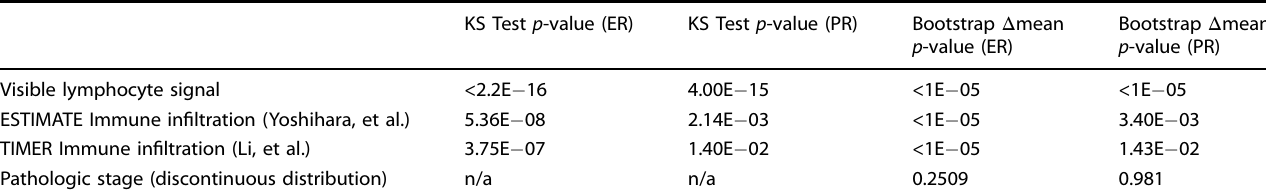
Table 4. The distinction between receptor status positive/negative patients: comparative performance of image/gene expression-based measurements of immune in fi ltration for separating receptor